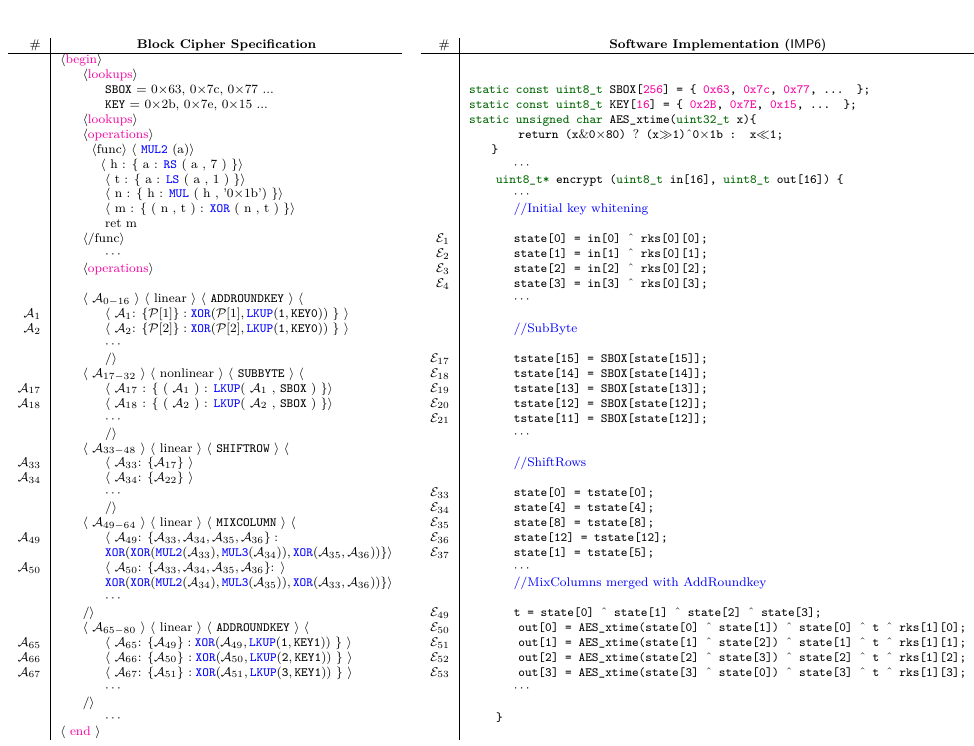
Figure 3: 1 st round representations of AES in BCS and Software